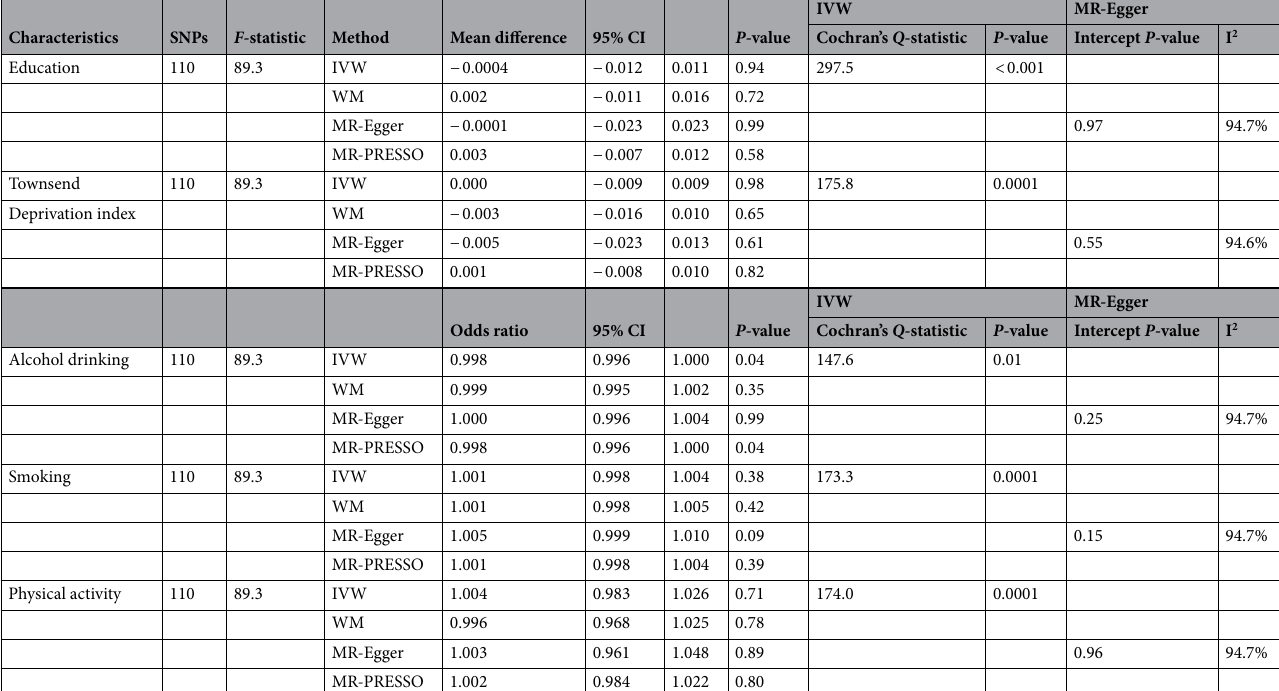
Table 1. Association of genetically predicted atrial fibrillation with socio-economic position (education, and Townsend deprivation index) and lifestyle (smoking, alcohol drinking, and physical activity) from the